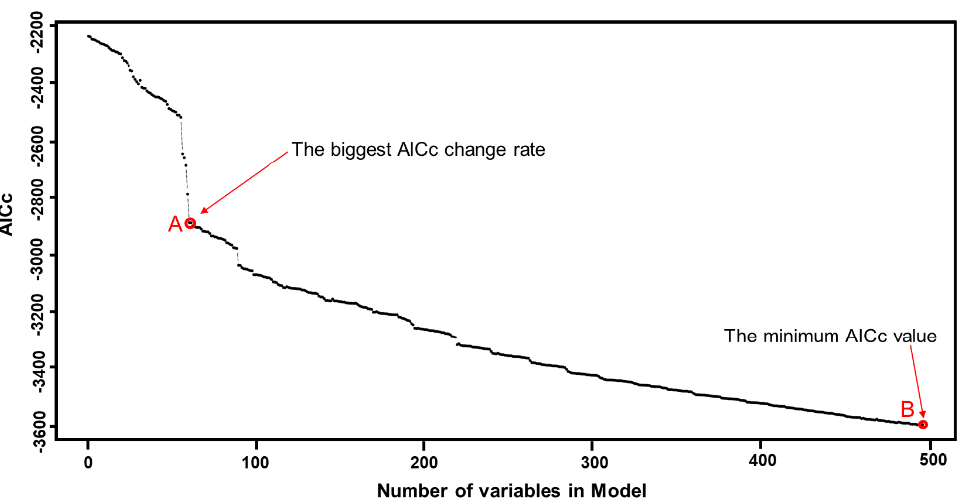
Figure 7. AICc values of different feature combinations derived from the forward stepwise strategy in Section 3.1.2. Each point corresponds to one vortex circle in Figure 4.